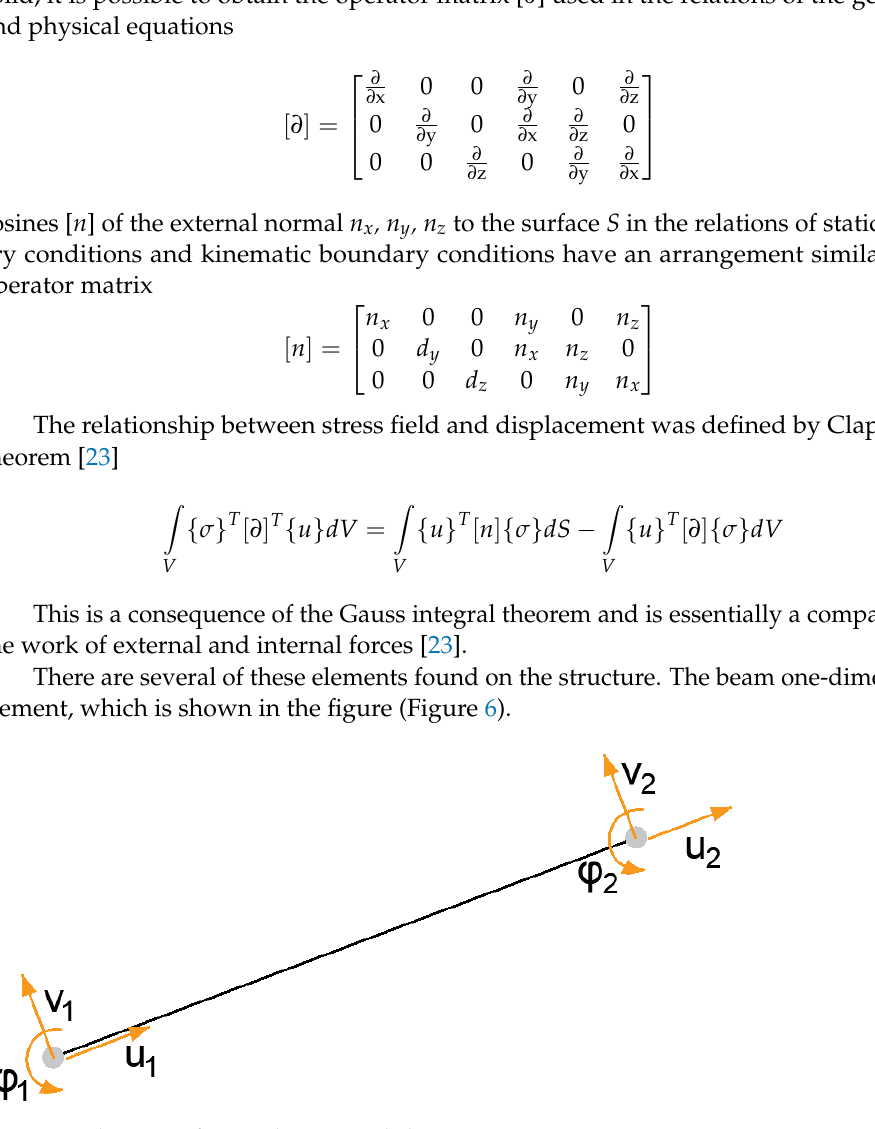
Figure 6. Schematic of a one-dimensional element.